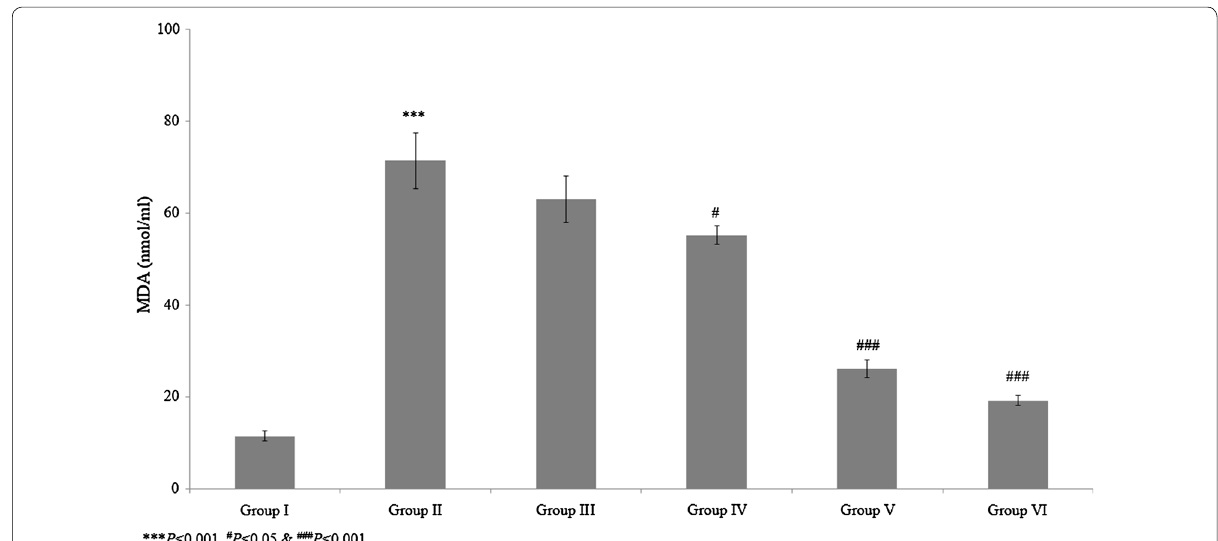
Fig. 2 Effects of erythropoietin and sesame oil on malondialdehyde (MDA) levels in rats with ischemic kidney injury after kidney transplantation. *** P < 0.001 vs. sham rats; # P < 0.05 and ### P < 0.001 vs. control rats